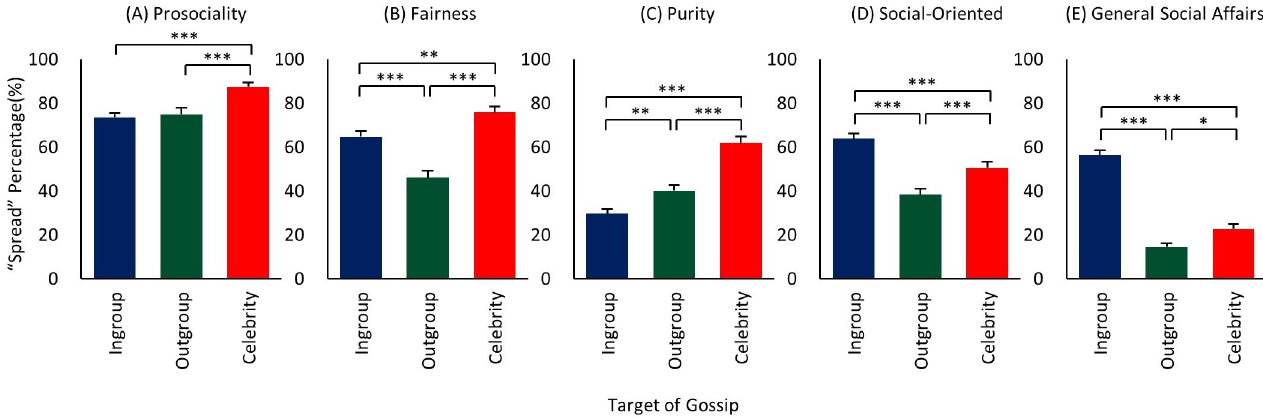
Fig 8. Mean gossip spread rates of 2-way interaction ‘content x target’. (A)-(C) Mean spread rate of ingroup, outgroup, and celebrity gossip for social- oriented, general social affairs, and purity, respectively. � p < 0.05, �� p < 0.01, ��� p < 0.001.